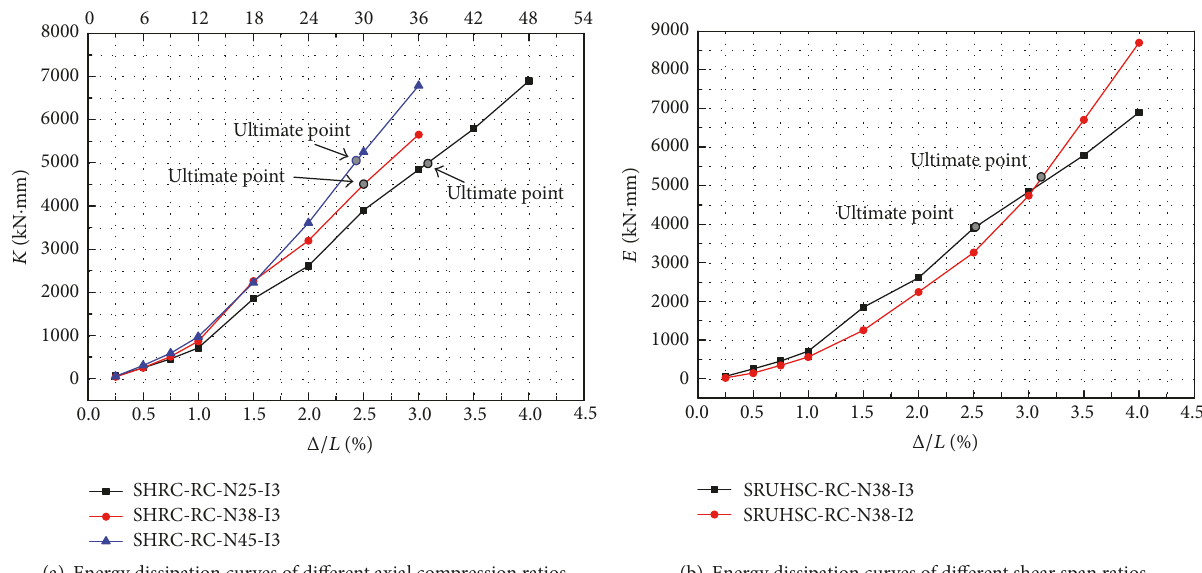
Figure 11: Energy dissipation of the